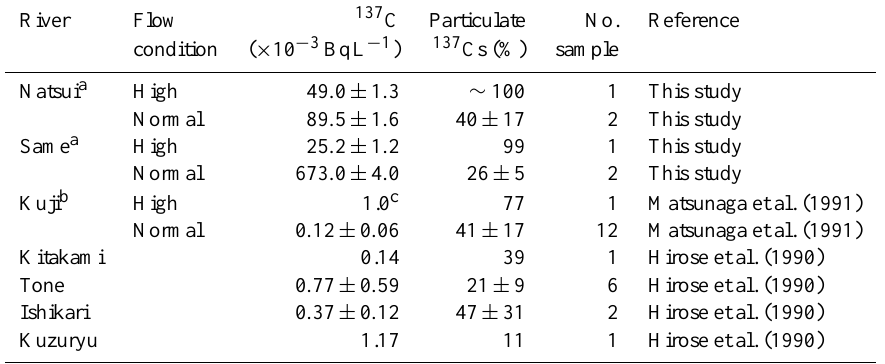
Table 2. Percentage of 137 Cs associated with suspended solids in Natsui River and Same River waters at low and high flow conditions River Flow 137 C Particulate No.